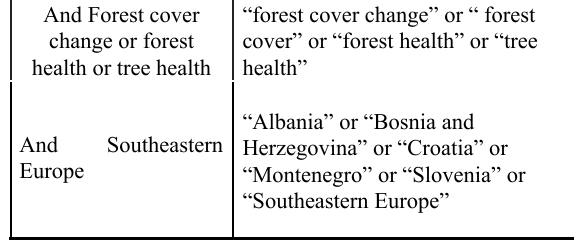
Table 1 . Search terms of Scopus and Google scholar